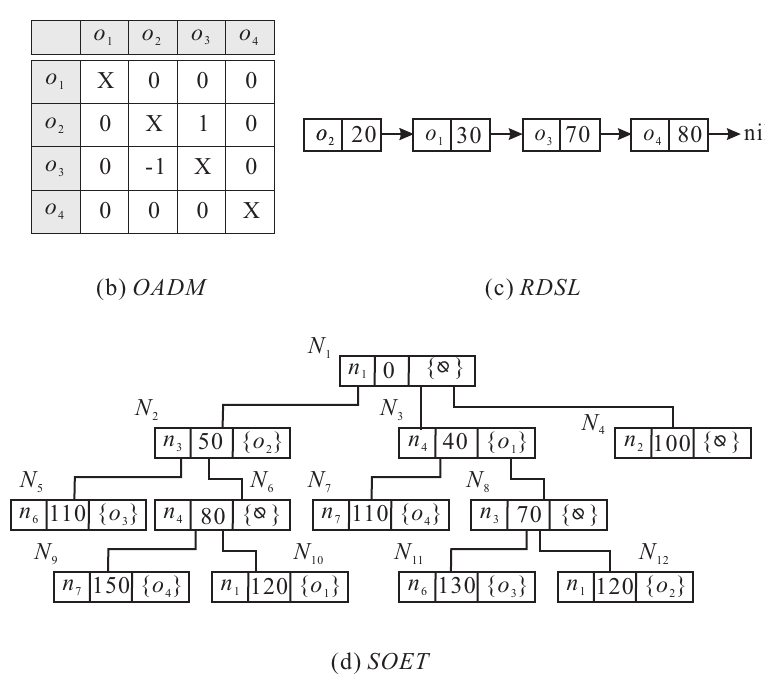
Figure 2. Three data structures: object attribute dominating matrix (OADM), the road distance sorted list (RDSL) and the skyline object expansion tree